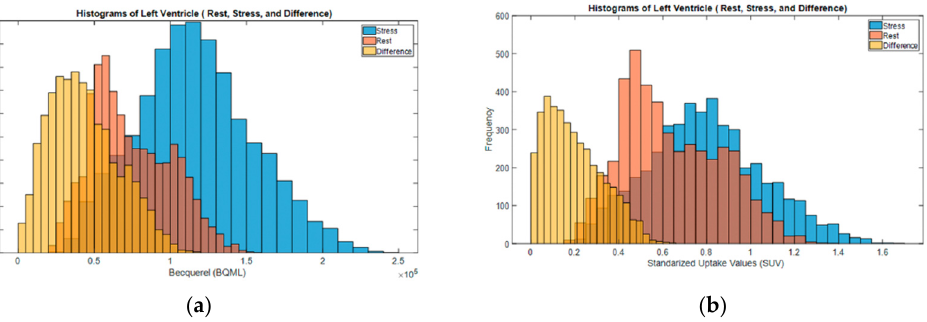
Figure 4. Histograms of FDG RBC tracer activity in the LV myocardial wall of a representative rat (Stress, after-stress = “rest” and the net difference). ( a ) Tracer activity (Bq/mL) in the LV myocardium. ( b ) Standardized uptake value (SUV) in the LV myocardium.